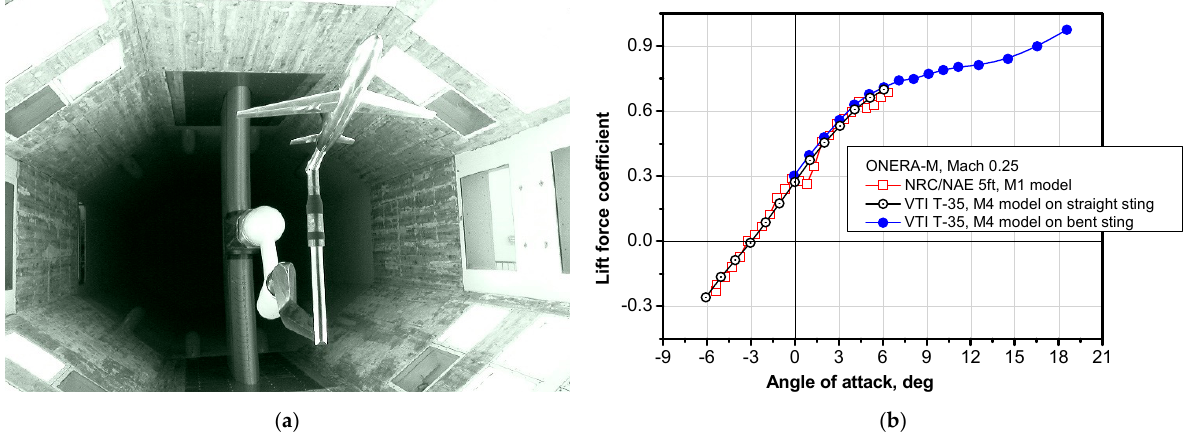
Figure 11. ( a ) ONERA − M4 model in the T-35 wind tunnel; ( b ) high AoA test data of the ONERA-M4 model obtained in the T-35 wind tunnel [37].